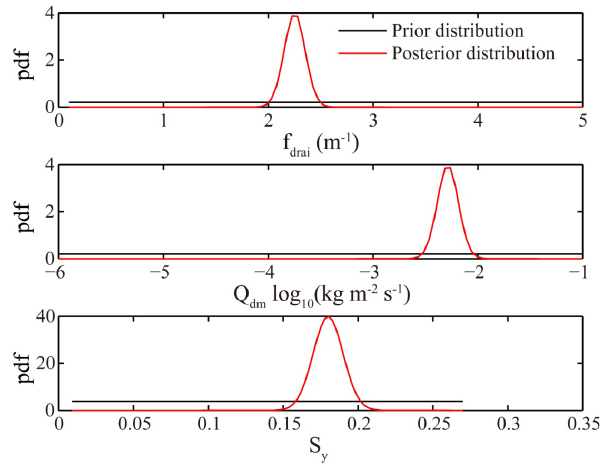
Figure 11. Posterior distribution of the reduced parameter set from previous sensitivity analysis at the MOPEX basin, with a reference acceptance probability of 1.0.